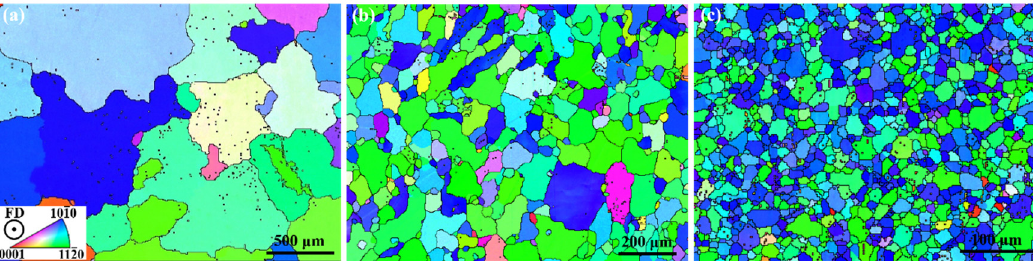
Figure 2. EBSD inverse pole figure (IPF) images of the as-homogenized and as-extruded alloy bars: ( a ) HS-0 sample; ( b ) E9S-0 sample; ( c ) E25S-0 sample. The observation planes are vertical to the feed direction (FD).